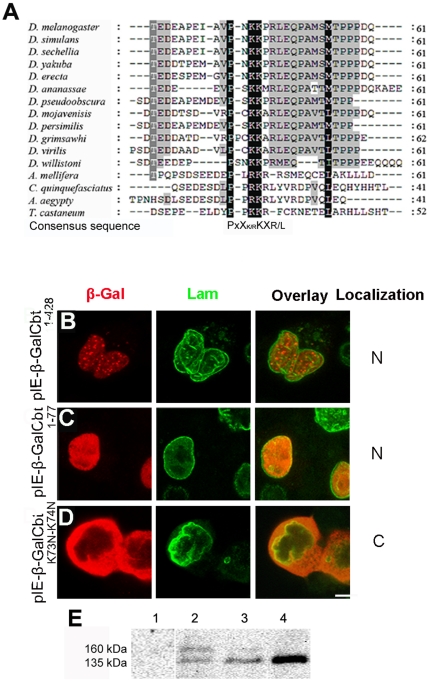
The PNKKPRL sequence is conserved and functional in insect Cabut orthologs.(A) Multiple alignment of Cbt proteins from Drosophila species and other insects, showing that the PNKKPRL motif is highly conserved. A consensus sequence for the putative NLS is shown below (X = any amino acid). (B–D) Localization of β-Gal fusion proteins in Spodoptera exigua Sec301 cells transiently transfected with the constructs shown in (A). Cells were stained with anti-β-Gal (red; first panel) and anti-Lam (green; second panel) to mark nuclear membranes. The overlay panel depicts double staining of cells with both antibodies, and the localization of the fusion proteins is shown in the fourth panel (C, cytoplasmic; N, nuclear). Note that all β-Gal fusion proteins containing the wild-type PNKKPRL sequence were translocated to the nucleus. Scale bar: 10 µm. (E) Western blots of protein extracts from Sec301 cells transfected with constructs shown in (A) and stained with anti-β-Gal. (1) Non-transfected Sec301 cells, (2) pIE-β-Gal-Cbt1–428 (∼160 kDa), (3) pIE-β-Gal-Cbt1–77 (∼135 kDa) and (4) pIE-β-Gal-Cbt1–K73N–K74N (∼135 kDa).